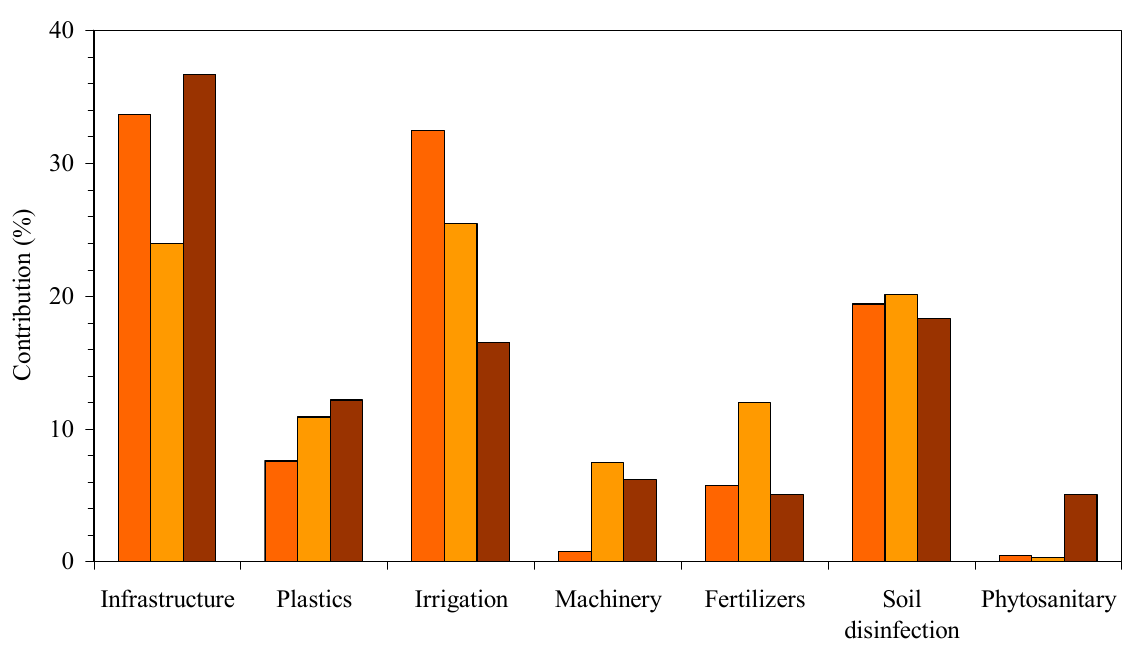
Figure 4. Contributions of the system components to the normalized environmental impacts, specifically to GW, and to the production costs. In the latter, each contribution was calculated without taking into account those aspects that do not represent an environmental impact (manpower) or that are not taken into account in the LCA (seedling production, biological control).